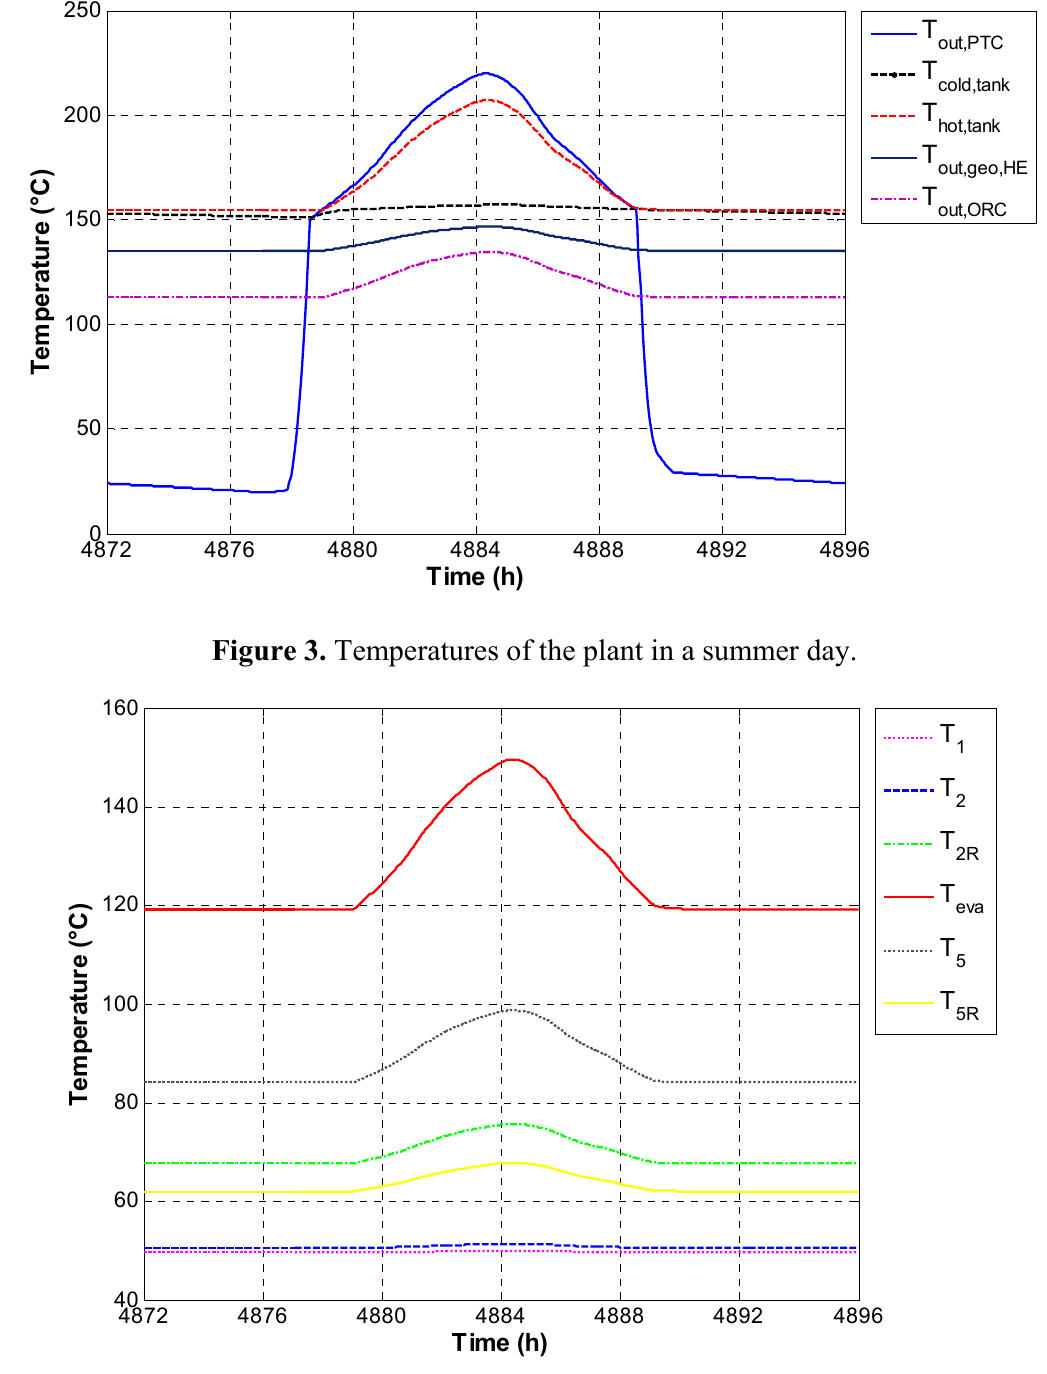
Figure 4. ORC temperatures in a summer